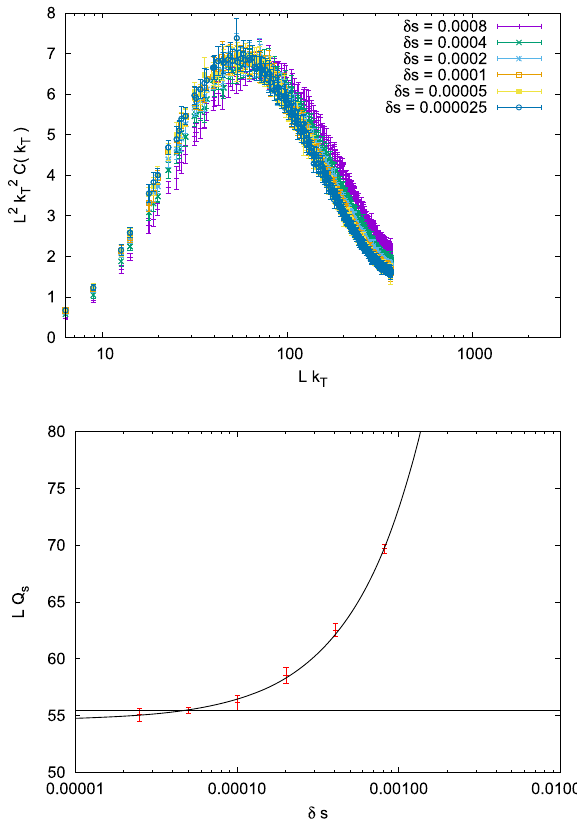
Fig. 10 Comparison of the evolved two-point correlation function as a function of the volume. Evolution to s = 0 . 04 with time step δ s = 0 . 0001. Infinite volume extrapolation is attempted demonstrating the saturation scale divergence in the volume parameter. The fit ansatz is f ( a / L ) = b + c L with b and c fit parameters. Similar behaviour was a found for the sine kernel